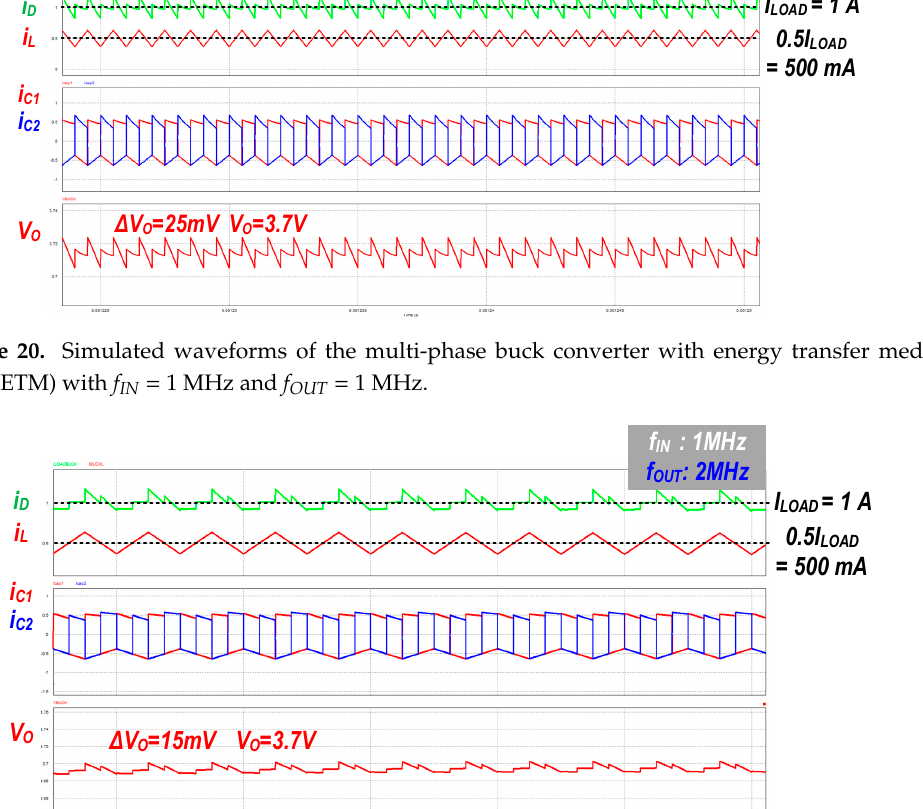
Figure 21. Simulated waveforms of the MBKETM with f IN = 1 MHz and f OUT = 2 MHz.